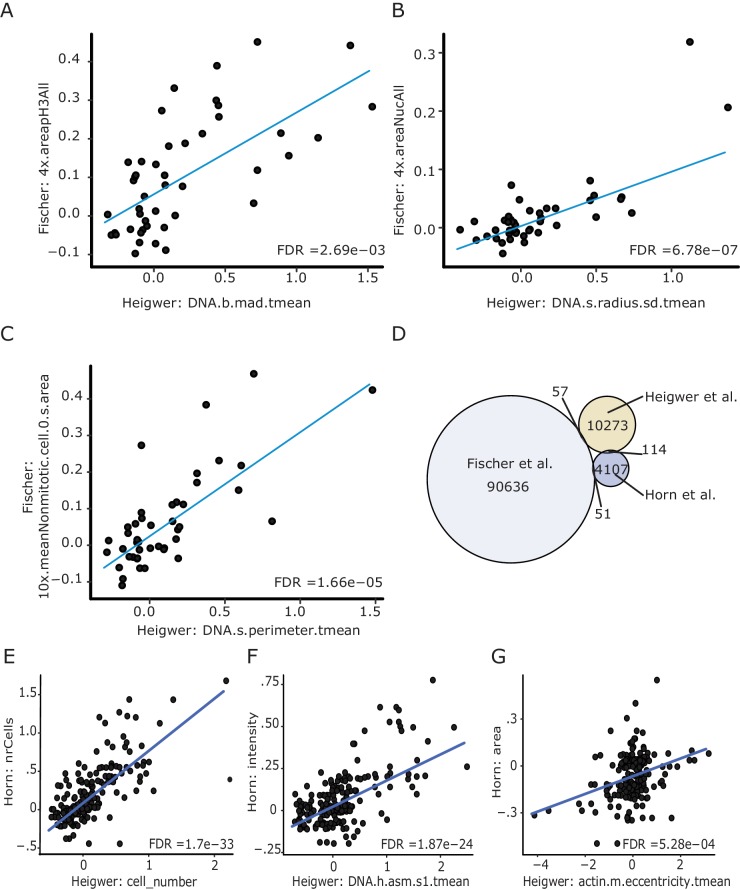
Image derived phenotypes closely resemble those of preceeding screens.(A–C) Starting with measurements of genetic interacton strength (π-score) of all bi-genic combination that were screened in Fischer et al. and this study we found a number of highly correlating features measuring: (A) DNA distribution in the nucleus, (B) radius of the nucleus, (C) area of the cell and the nulceus (Fischer et al., 2015; Horn et al., 2011). (D) Venn Diagram showing the overlap and uniquely screened bi-genic Drosophila genetic interactions. To increase the reate of novel findings but retain backwards comparability all screens contain minimal overlap and add to the larger map of synthetic genetic interactions of the fly cell. (E–G) Sustantial comparability between Heigwer and Horn et al.